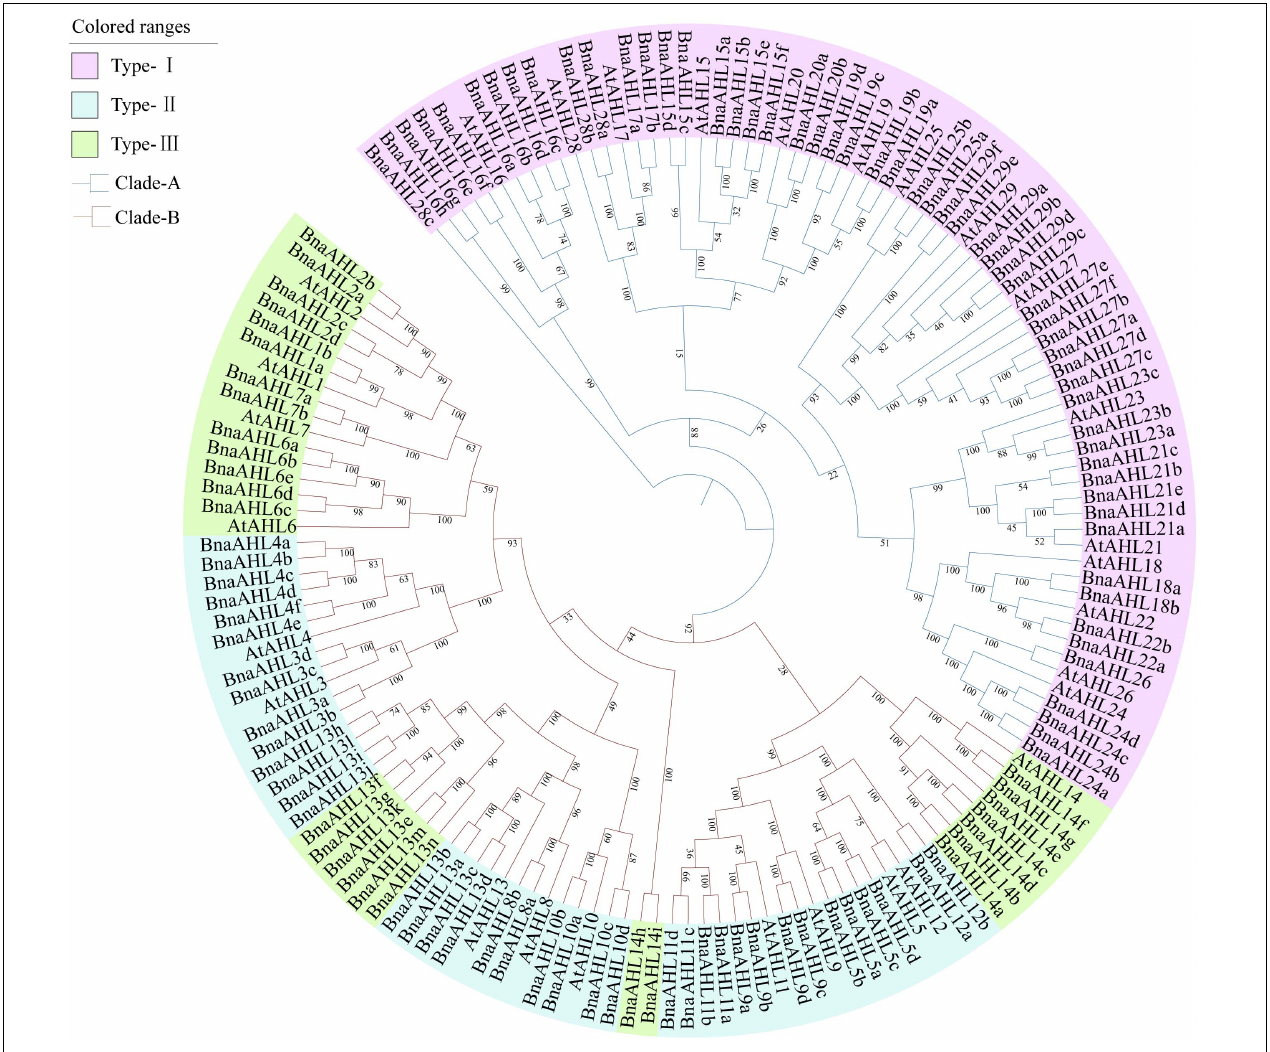
FIGURE 1 | Phylogenetic relationship of AHL genes in B. napus and Arabidopsis . Branches of different colors indicate different evolutionary clades. Each branch has a number indicating the percentage of reliability of the evolutionary